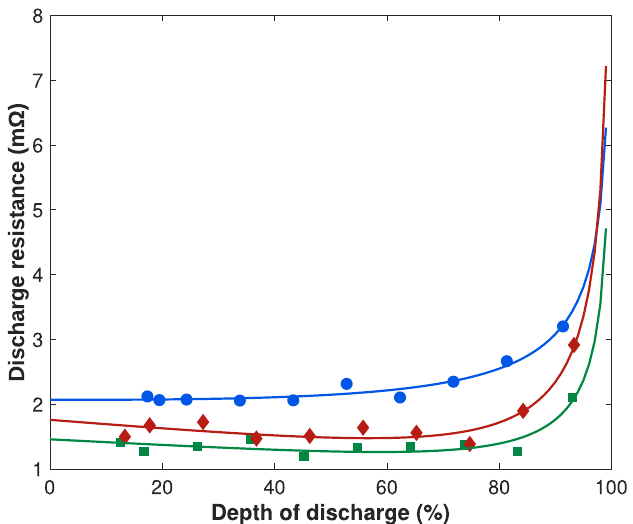
Figure 9. Experimental result and model response (lines) for 0 s discharge resistance versus depth of discharge and temperature 0 (blue), 25 (green) and 40 °C